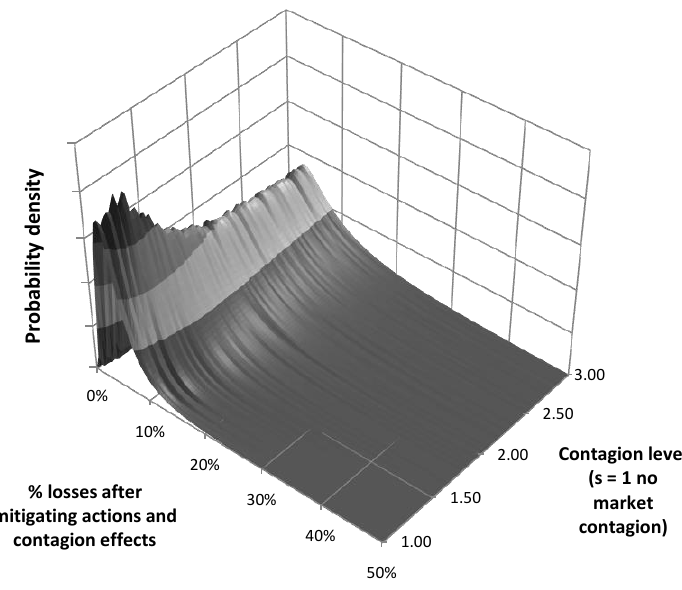
FIGURE 20: UK 2009, buffer restoration model output showing the dependence of loss probabilities on contagion level Source: Authors’ analysis